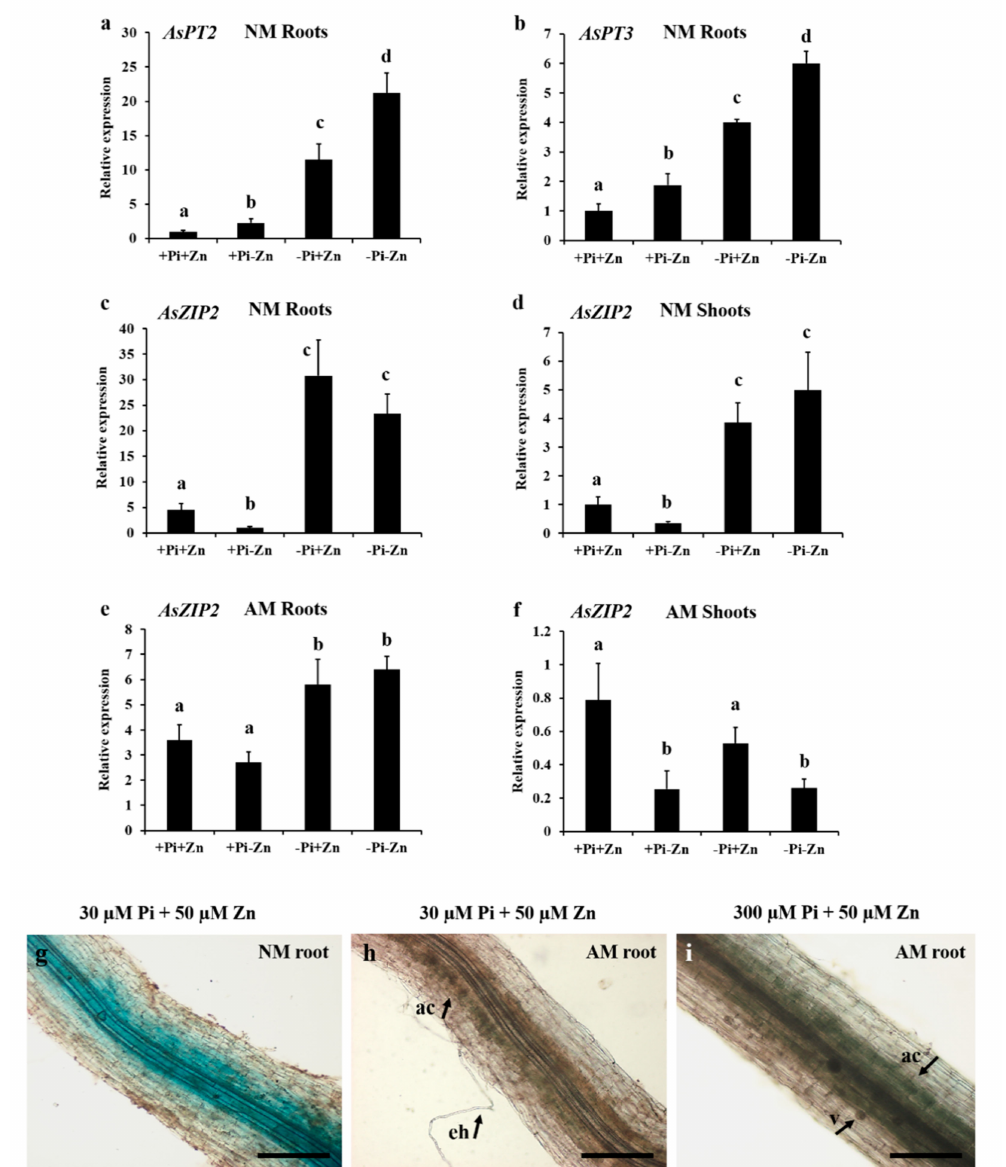
Figure 4. Expression profiles of the two PHT1 family members AsPT2/3 and one ZIP family member AsZIP2 in A. sinicus in response to Pi and/or Zn availabilities. A. sinicus plants were grown in cultures treated with 300 µ M Pi and 50 µ M Zn (+Pi+Zn), 300 µ M Pi and 0.5 µ M Zn (+Pi-Zn), 30 µ M Pi and 50 µ M Zn (-Pi+Zn) or 30 µ M Pi and 0.5 µ M Zn (-Pi-Zn). ( a – f ) Fourteen-day-old A. sinicus seedlings were colonized by R. irregularis at 42 dpi, and roots and shoots of 56-d-old plants were collected separately with transcription levels of target genes quantified by real-time qRT-PCR. ( a – d ) Gene expression in NM A. sinicus plant tissues; ( e , f ) Gene expression in A. sinicus plants under AM conditions. The AsActin gene for A. sinicus was used as the house-keeping gene for normalization. Error bars mean standard deviation from three biological replicates. The different letters are statistically significant differences among treatments at p < 0.05, based on Duncan’s multiple range test. ( g – i ) GUS staining of pAsZIP2::GUS transgenic NM ( g ) and AM ( h , i ) roots of A. sinicus grown under low Pi and/or moderately high Zn conditions as indicated. A. sinicus roots colonized by R. irregularis at 42 dpi. NM, nonmycorrhizal; AM, arbuscular mycorrhizal; ac, arbuscule-containing cells; eh, extraradical hyphae; v, vesicles. Scale bars, 100 µ